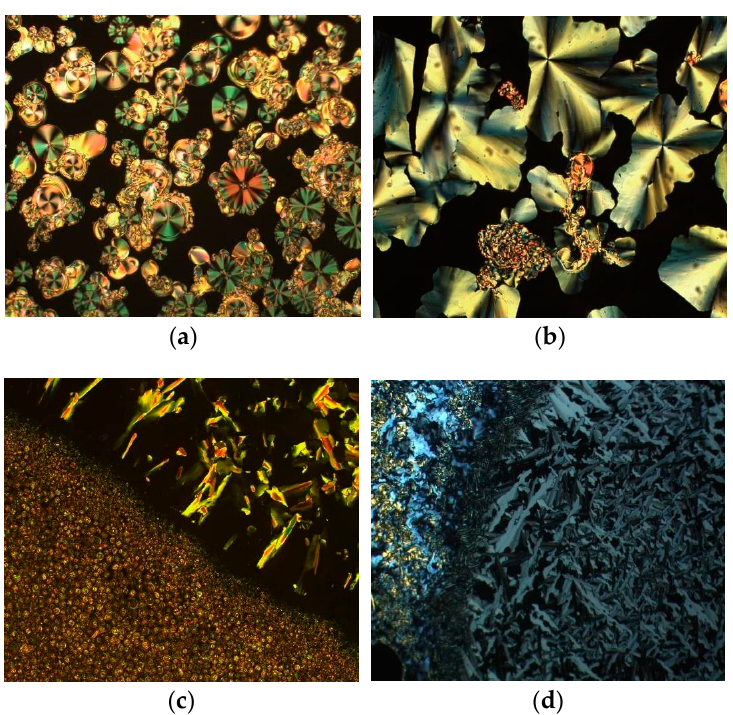
Figure 8. Photomicrographs of the Col r phase formed by compound 5 -8: ( a ) cooling from the isotropic liquid at 10 °C min -1 at 158 °C, ( b ) slow cooling of the same compound at 0.1 °C min -1 at 159 °C, ( c ) miscibility gap between this phase and the Col h phase of the OTf compound 1 -18 ( 5 -8 is bottom left and 1 -18 is top right) and ( d ) miscibility gap between the phase of 5 -8 (top and left) and the SmA phase of the OTf compound 1 -12 (right). Table 1. Diffraction data for series 5 - n .